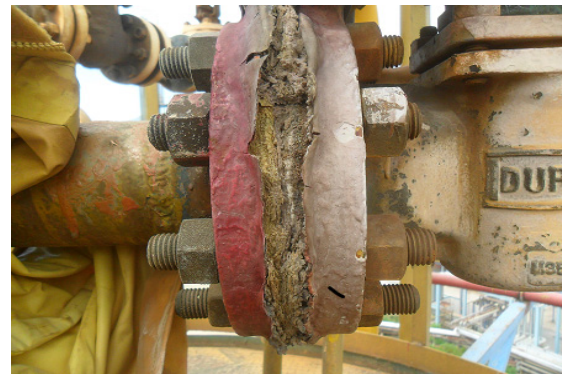
Figure 4. Typical flange leakage morphology.